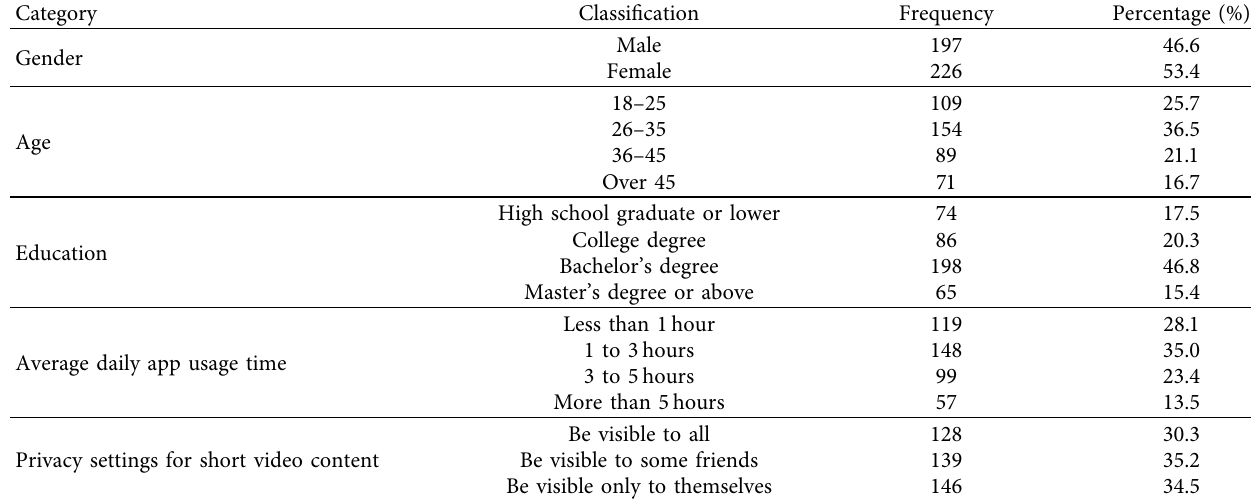
Table 2: Sample population characteristics ( N � 423).